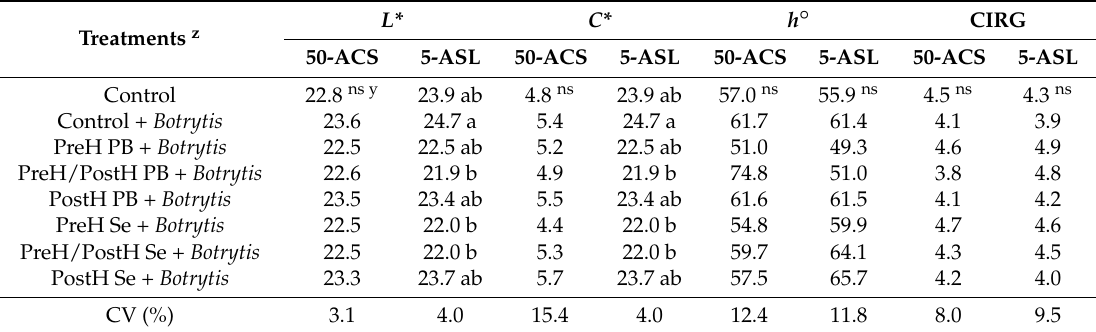
Table 5. Color attributes of luminosity ( L* ), chroma ( C* ), hue angle ( h° ) and color index of red grapes (CIRG) of ‘BRS Isis’ seedless table grapes subjected to preharvest (PreH), pre- and postharvest (PreH/PostH) and postharvest (PostH) treatments, at 50 days after cold storage (50-ACS) and at five days of shelf-life (5-ASL).